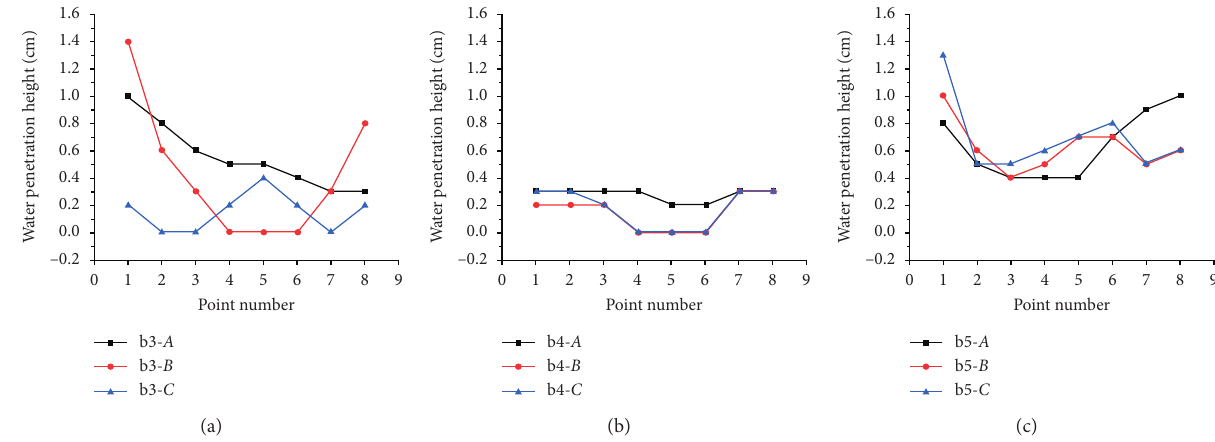
Figure 13: Measured values of the water exudation height of specimens (a) b3, (b) b4, and (c) b5. Data for three separate specimens A (black), B (red), and C (blue) are displayed in each figure.